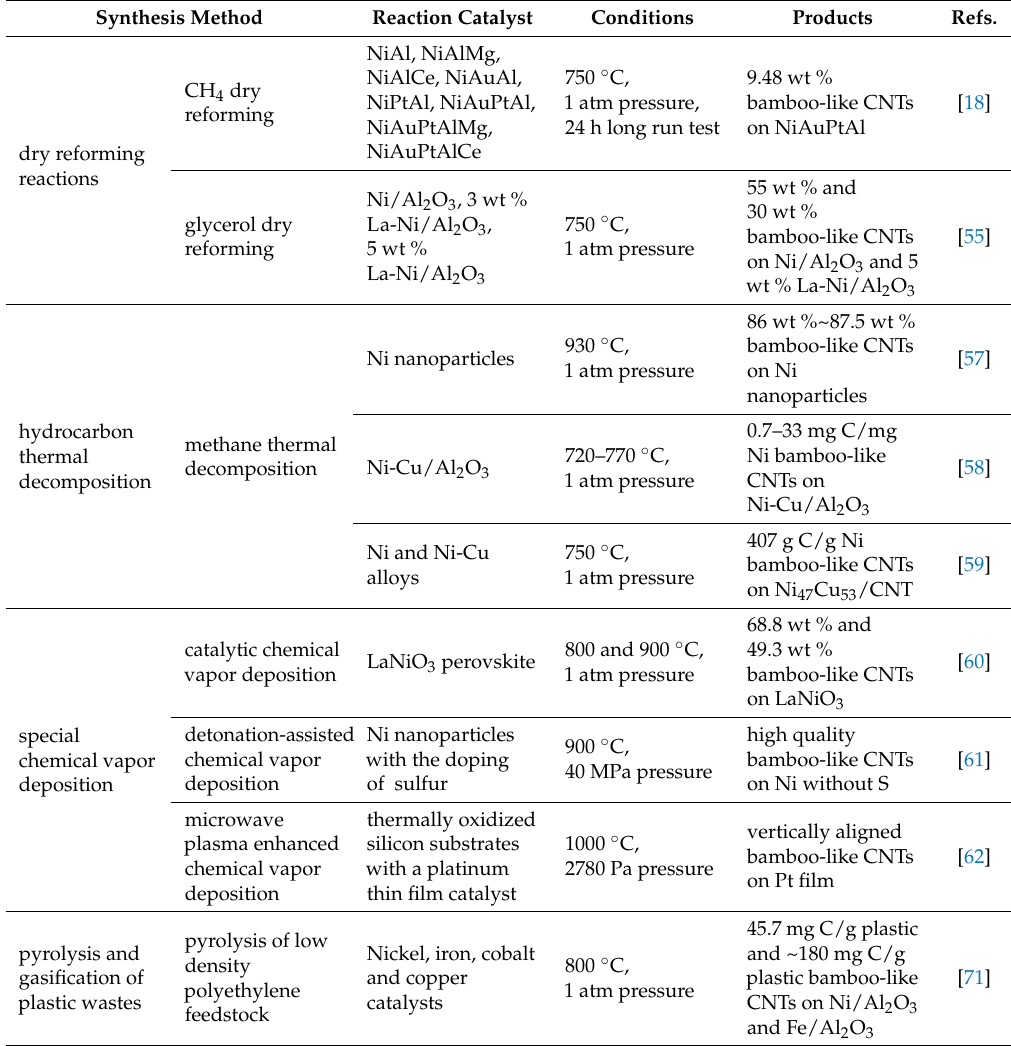
Table 1. The synthesis method of bamboo-like carbon nanotubes over different catalysts, their morphological and structural characterization along with the experimental conditions